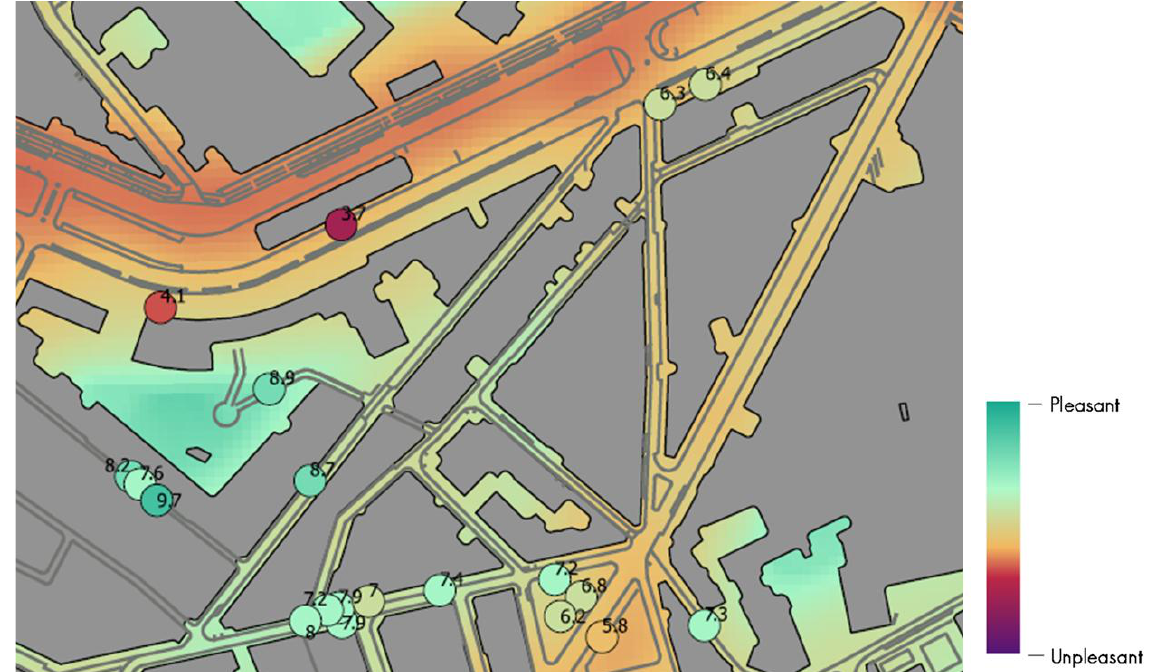
Figure 18: Modelled sound quality around the Boulevard Blanqui (on the top of the map) during a market day. The circles represent the mean values of the assessed pleasantness. The red dots on the boulevard correspond to the mean assessments carried out on a day with- out the presence of the market. The light green dots on the same boulevard correspond to the mean assessments during a market day.